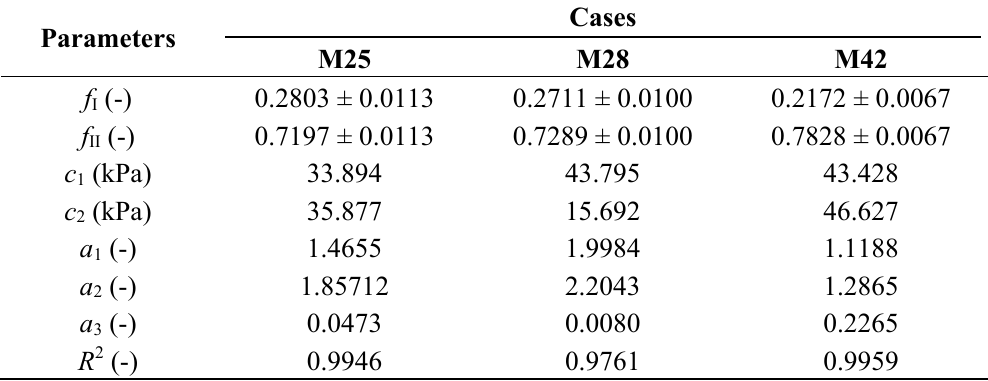
Table 1. Computed volume fractions and obtained material parameters for the three cases